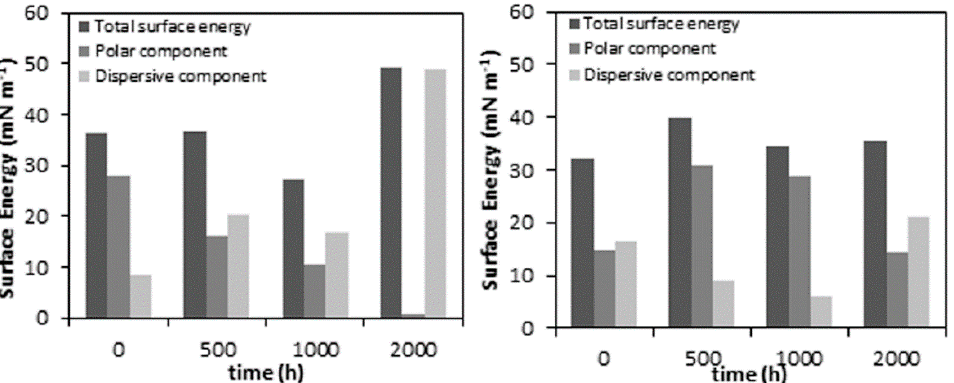
Figure 8. Surface energy of neat PLA (left) and PLA / TiO 2 (right) as a function of increasing weathering exposure time.